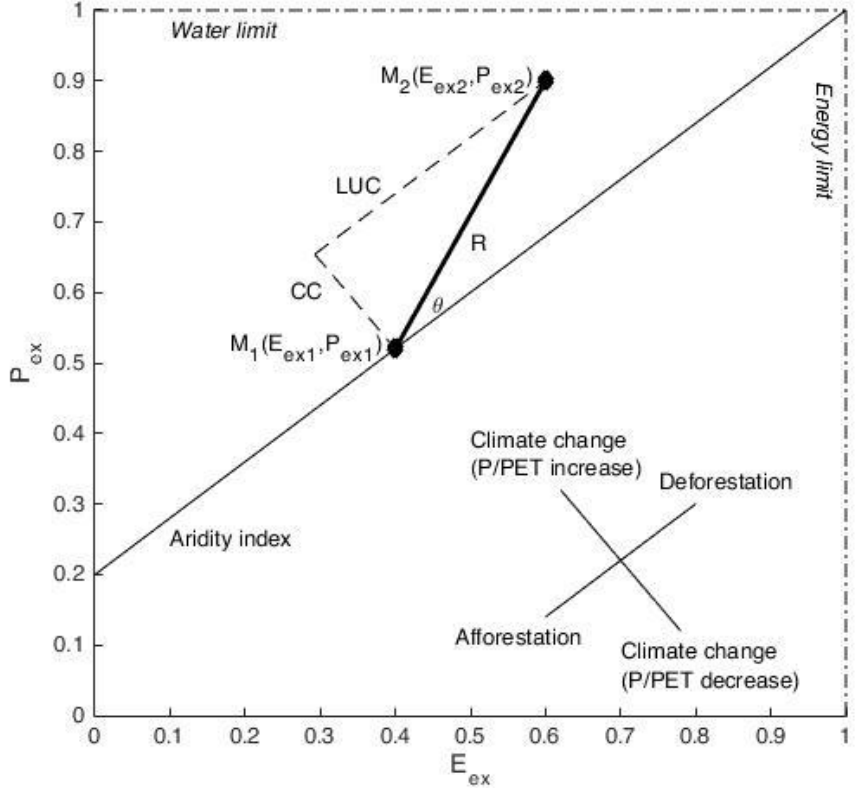
Figure 2. Adapted Tomer and Schilling [13] framework illustrating how the fractions of excess water and excess energy respond to climate and land-use changes. The points M 1 and M 2 are the fractions of excess water and energy of the pre-change period ( P ex 1 , E ex 1 ) and the post-change period ( P ex , E ex 2 ), respectively. The resultant length ( R ) is the magnitude of the combined influence of land use and climate changes.